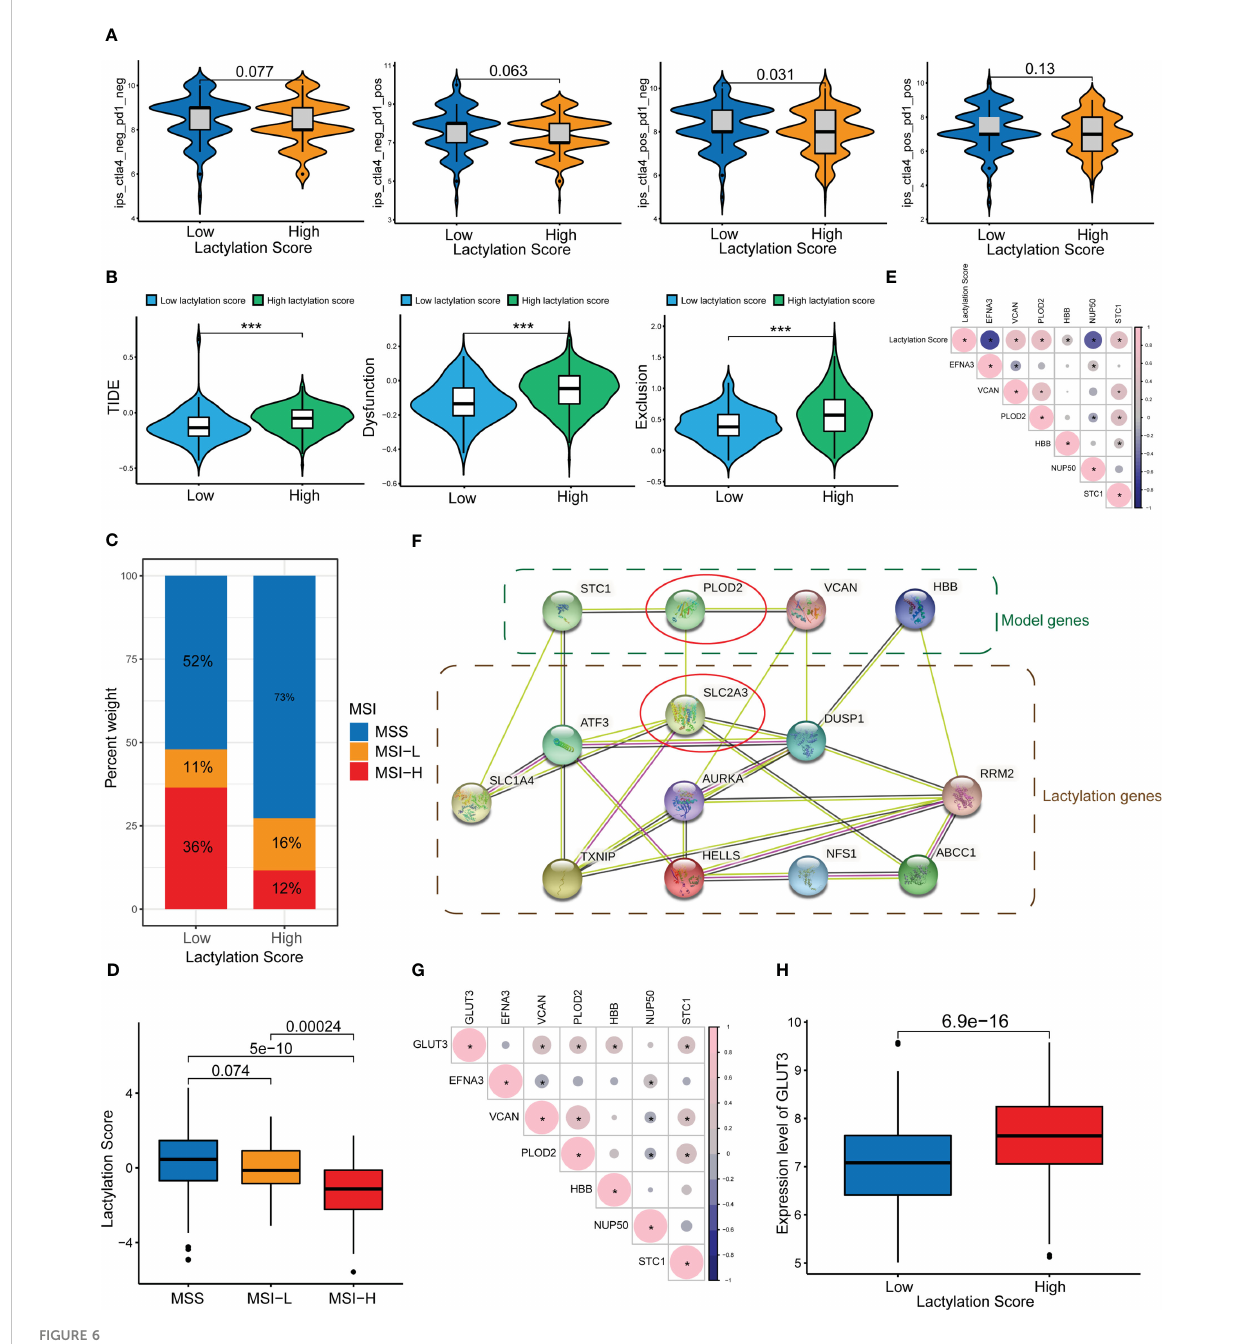
FIGURE 6 ICIs and immune evasion. *p<0.05; ***p<0.001. (A) Sensitivity analysis of the high- and low-lactylation-score groups to immunotherapy. (B) TIDE score, Dysfunction score, and Exclusion score of the high- and low-lactylation-score groups. (C, D) Microsatellite instability in the high- and low- lactylation-score groups. (E) Correlations between the lactylation score and lactylation-related gene expression. (F) PPI network between lactylation- related proteins and lactylation target genes. (G) Correlation between GLUT3 and lactylation-related genes. (H) GLUT3 expression in the high- and low-lactylation-score